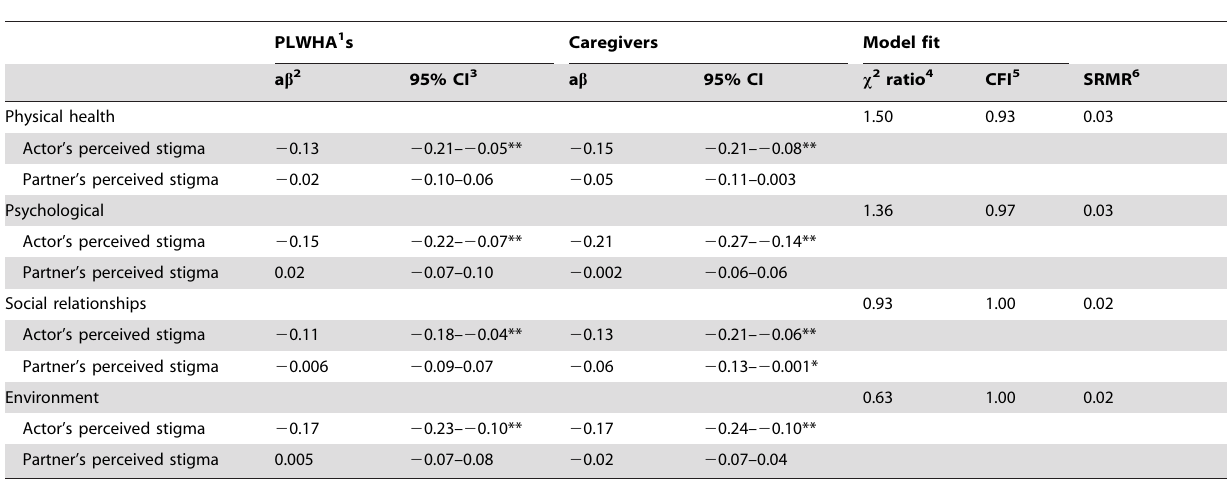
Table 3. Actor and partner effect of perceived HIV stigma on quality of